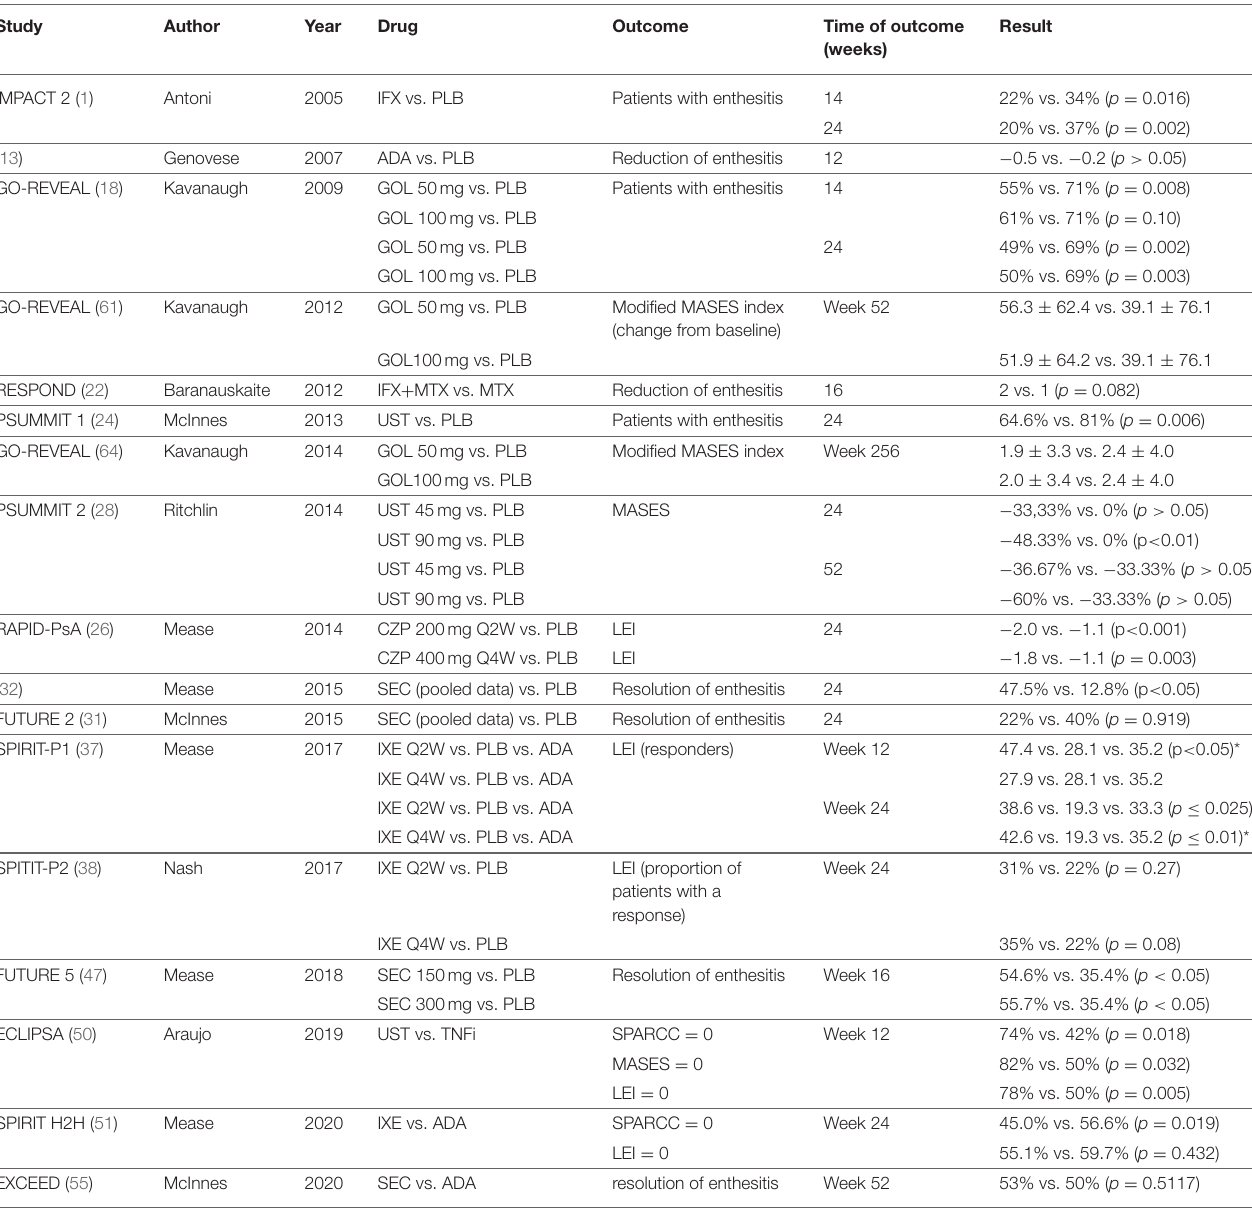
TABLE 5 | Enthesitis assessment in patients with psoriatic arthritis.